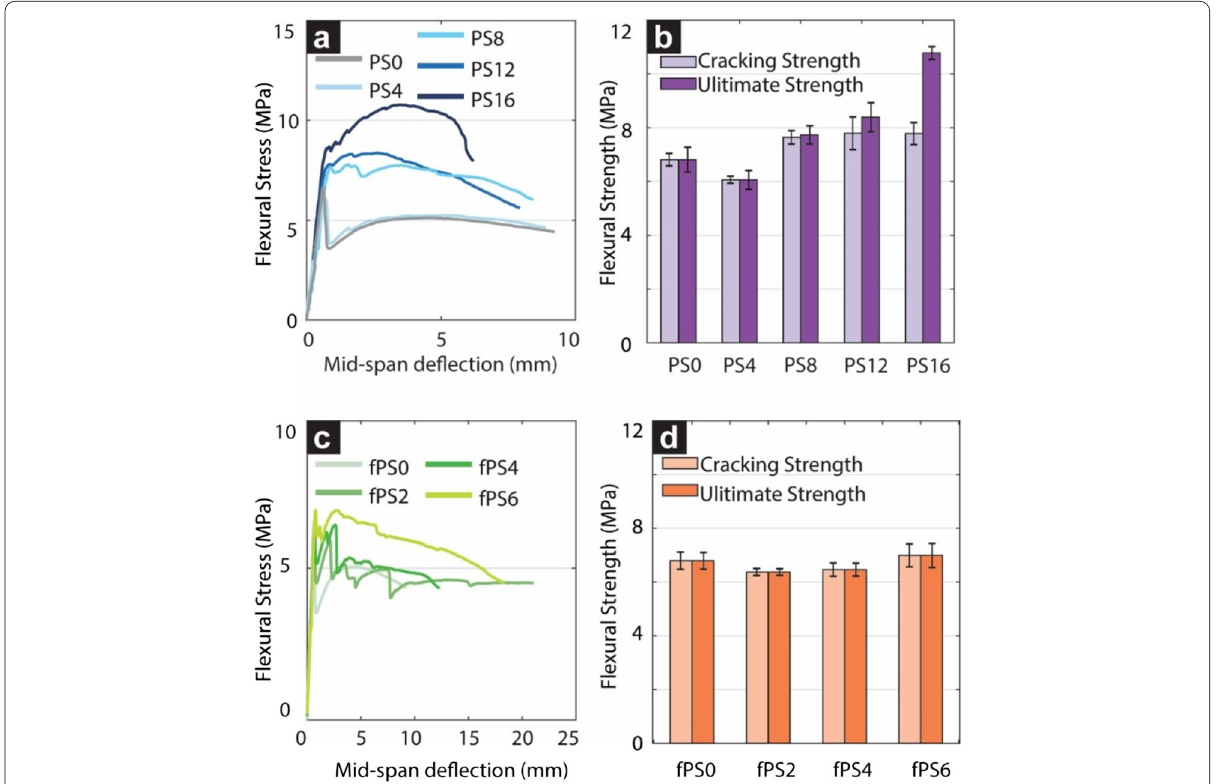
Fig. 8 a , c Load–mid-span deflection curve and b , d flexural strength for MPC mortar with 1.6% hybrid fibres and 1.6% PP fibres,